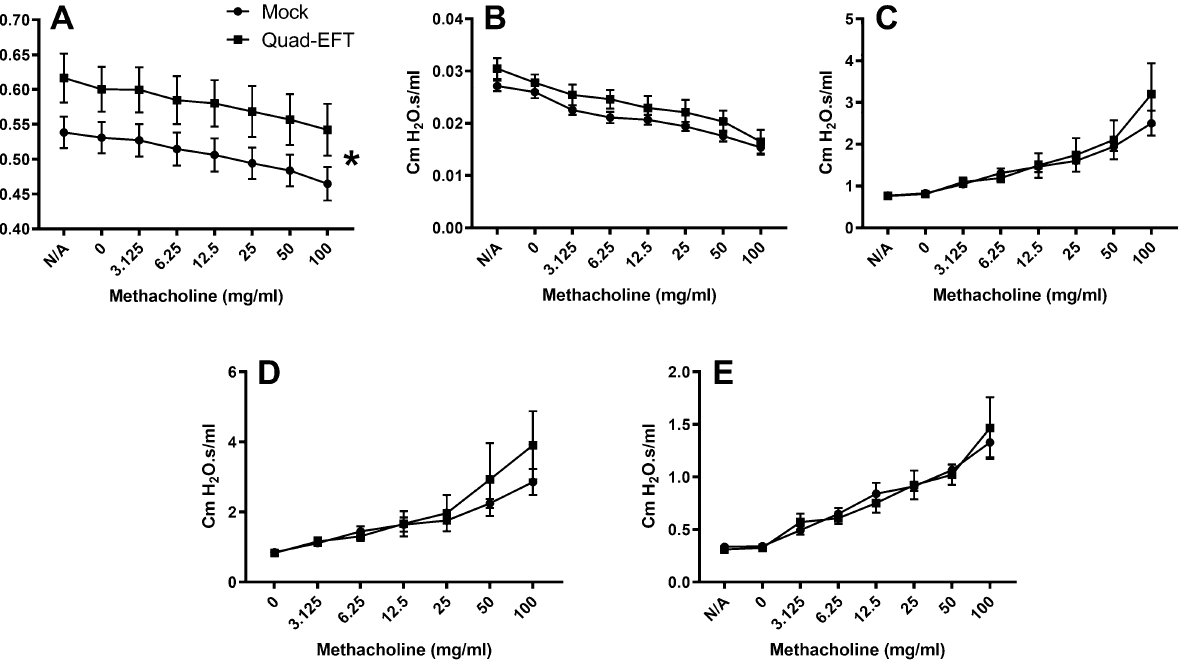
Figure 5. Lung function testing in EFT and mock-treated mice. Mice were subjected to the allergic inflammation model as in Fig. 4. Quad-EFT and Mock control groups were analyzed for lung function parameters using a flexiVent system at day 15. ( A ) Inspiratory capacity, respiratory system ( B ) compliance, ( C ) resistance, ( D ) maximum resistance, and ( E ) Newtonian resistance are shown. Data are shown as + / − SEM of n = 7–8 per group. * p < 0.05 by